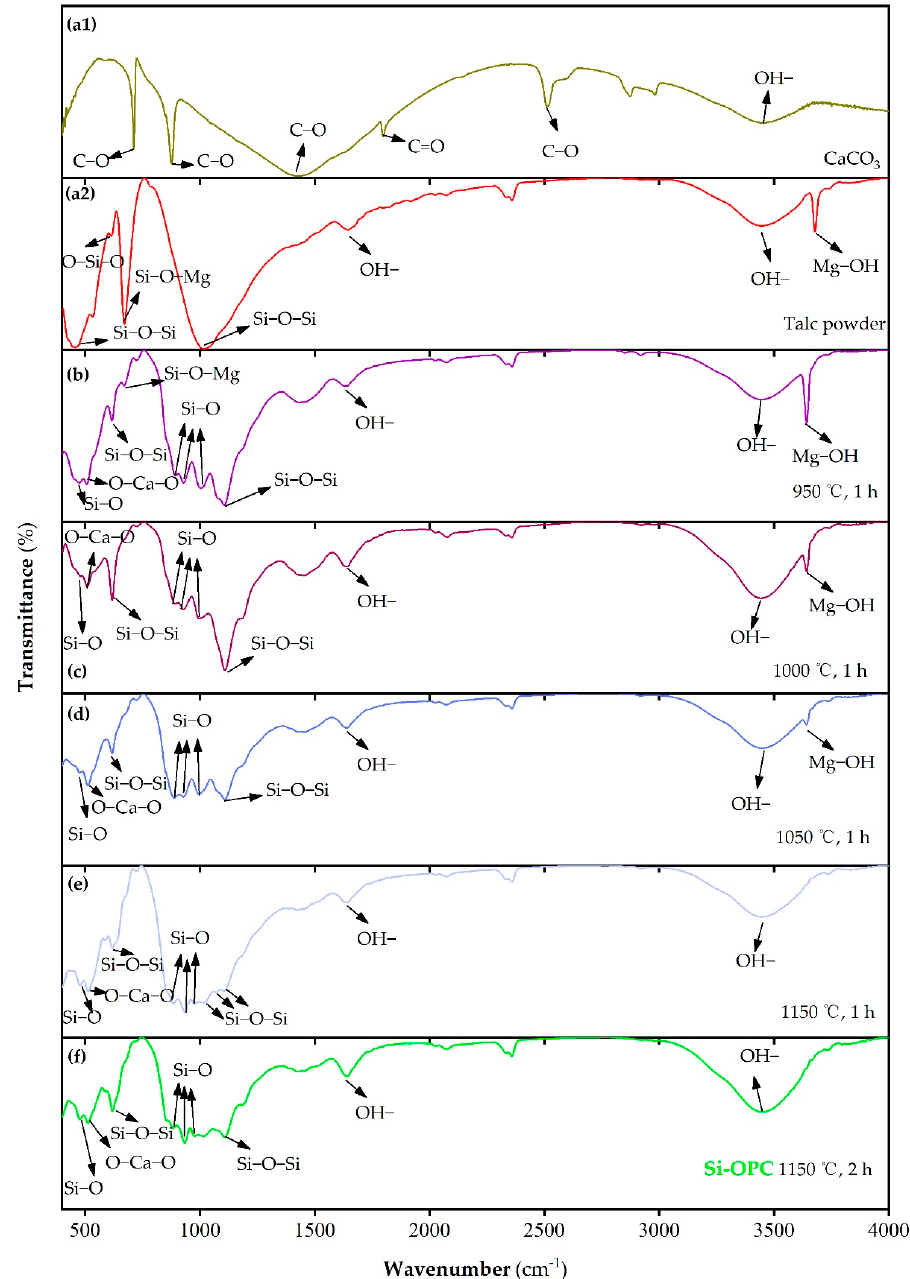
Figure 3. FTIR spectra of the ( a1 ) CaCO 3 , ( a2 ) talc powder and the prepared Si fertilizers after calcination at ( b ) 950 °C, ( c ) 1000 °C, ( d ) 1050 °C and ( e ) 1150 °C for 1 h, as well as ( f ) 1150 °C for 2 h (i.e., the Si-OPC). In all cases, n(Talc powder): ( c ) 1000 ◦ C, ( d ) 1050 ◦ C and ( e ) 1150 ◦ C for 1 h, as well as ( f ) 1150 ◦ C for 2 h (i.e., the Si-OPC). In all cases, n(Talc powder): n(CaCO 3 ) = 1:2. All samples were prepared as KBr pellets. n(CaCO 3 ) = 1:2. All samples were prepared as KBr